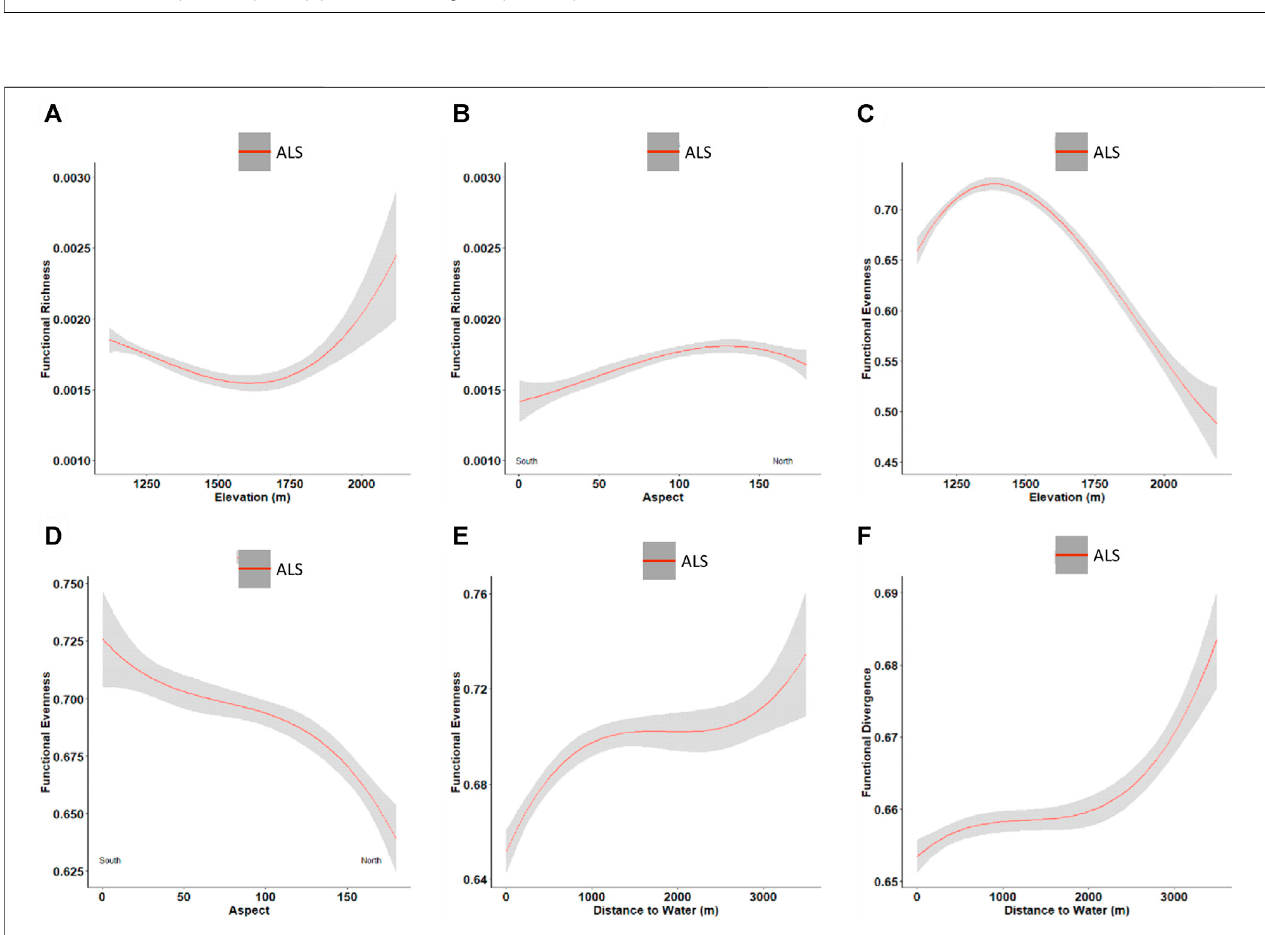
FIGURE4| TrendsbetweenALSpredicted functionaldiversityandabioticcontrols.Theredcurvesrepresentthemeanvariationofdiversityindicespredictedfrom ALS and the surrounding gray area represents the standard deviation. Functional richness with (A) elevation; (B) aspect. Functional evenness with (C) elevation; (D) aspect; (E) distance to water. Functional divergence with (F) distance to water.